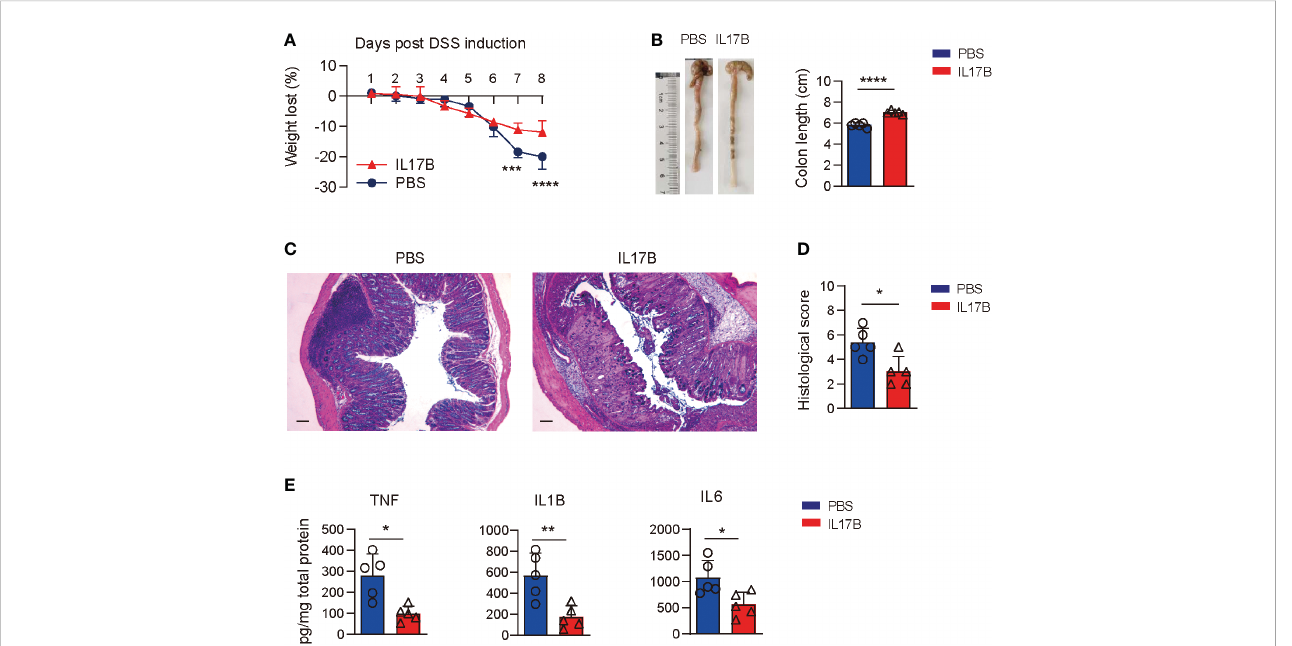
FIGURE 3 Rescue of IL17B alleviates the severity of colitis. Il17b -/- mice were induced colitis by feeding 2.5% DSS water and intraperitoneally (I.P.) injected with 0.5 m g of mouse IL17B (n = 4) or PBS (n=3). The treatment was performed 1 hour before the initial DSS administration and repeated every 48 hours for 4 times. (A) Body weight loss was measured daily. *** P < 0.001, **** P < 0.0001, evaluated by 2 way ANOVA analysis with Sidak`s multiple comparisons test. (B) The colon lengths were measured on day 8. (C) Representative H&E staining of colon tissues. Scale bar: 200 m m. (D) Quanti fi cation of histological score from colonic sections in (C, E) The supernatants of colon tissue homogenates were assayed for cytokine by ELISA. Data are mean ± SD. * P < 0.05, ** P < 0.01, **** P < 0.0001, evaluated by unpaired t